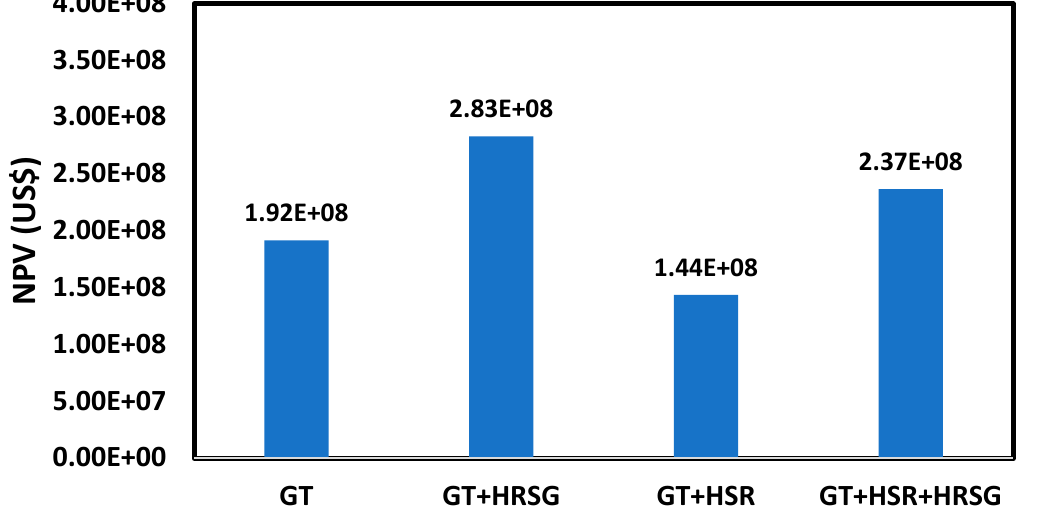
Figure 13. Net present value (NPV) for four types.